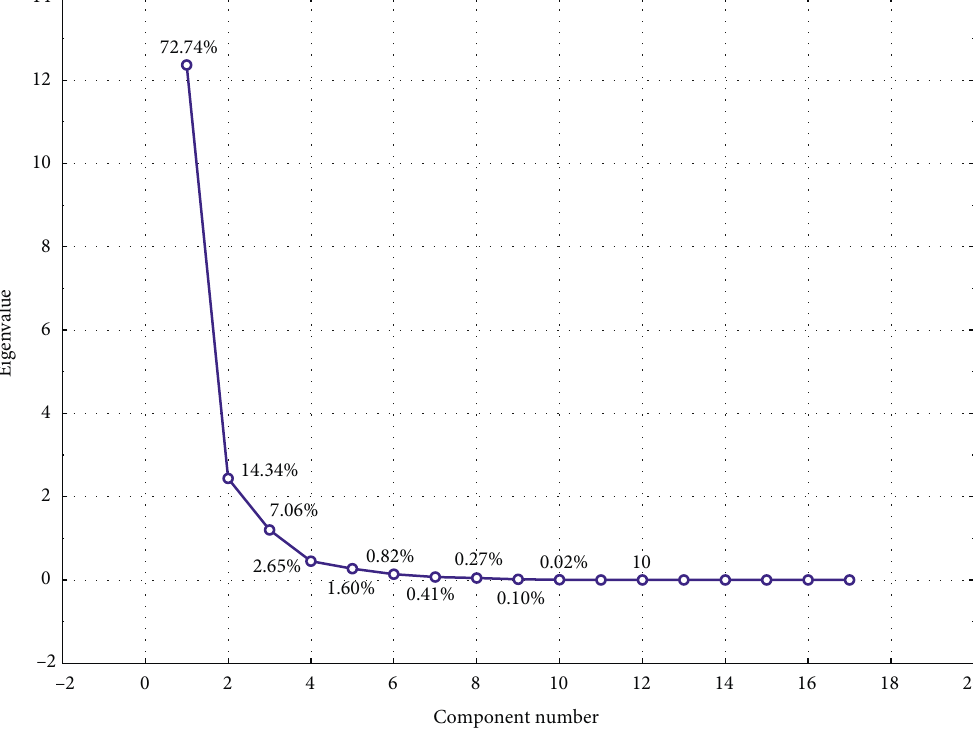
Figure 5: Scree plot for experimental and theoretical data analysed.